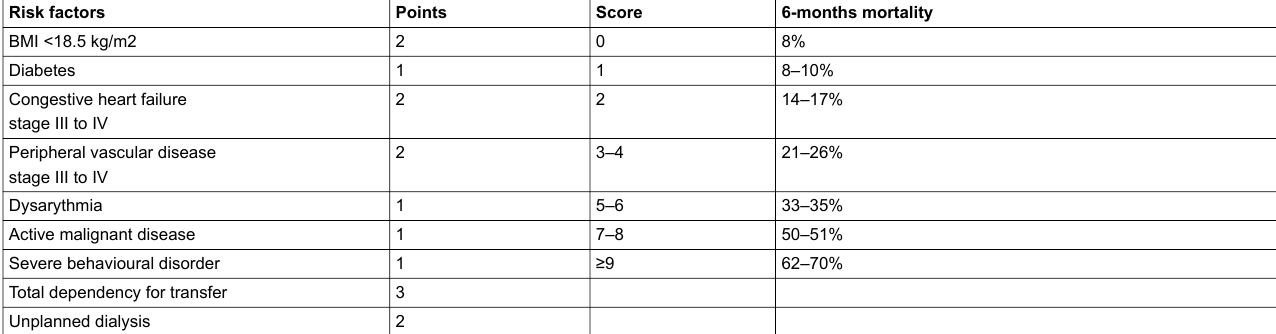
Table 2: REIN score to help clinical decision-making about whether to start dialysis or not in patients older than 75 years [15]. A Score ≥9 is associated with 70% 6-months mortality on dialysis [16]. Risk factors